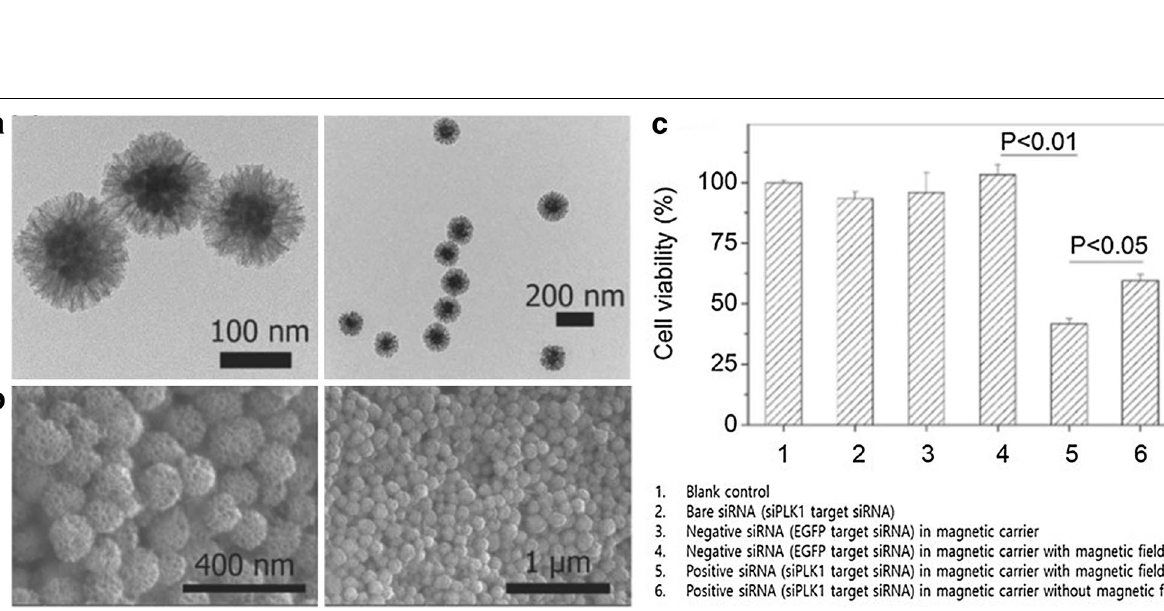
Fig. 4 a TEM and b SEM images of a siRNA carrier made of magnetic particles coated with mesopourous silica. c Cell viability after release of siRNAs (Reproduced with permission